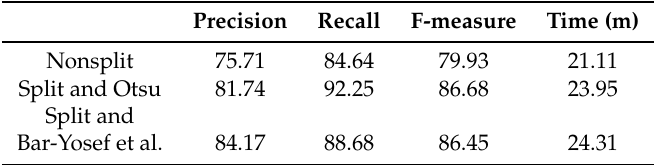
Table 4. Effect of using different binarization methods, Otsu and Bar-Yosef et al., together with the effect of splitting the touching characters among text lines.